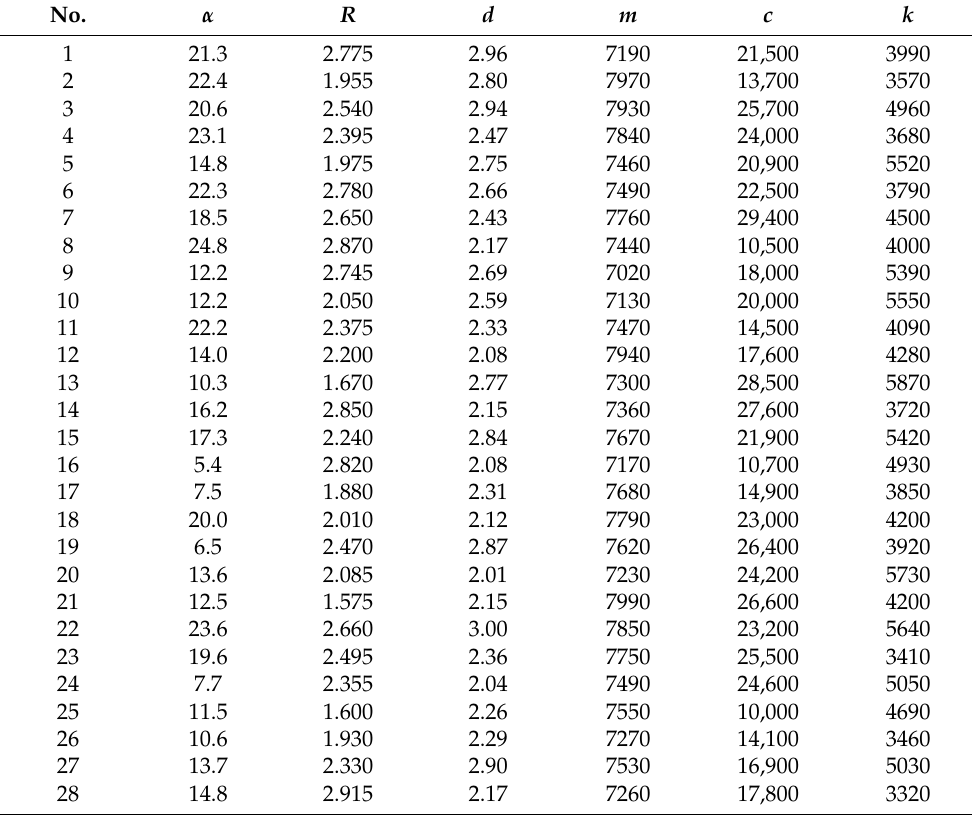
Table A1. Details of 100 sample